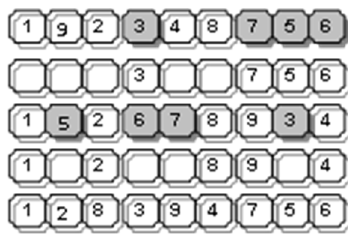
Figure 8. The PBX procedure.